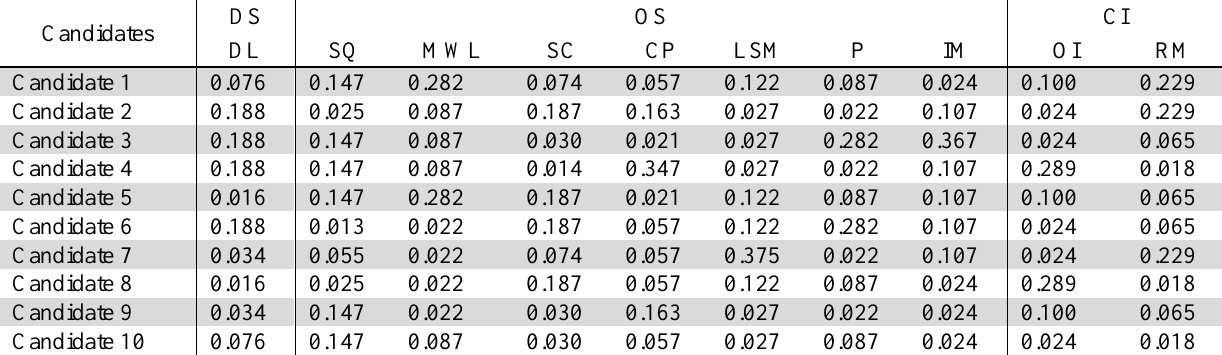
Weighting priority values for each candidate in each criterion